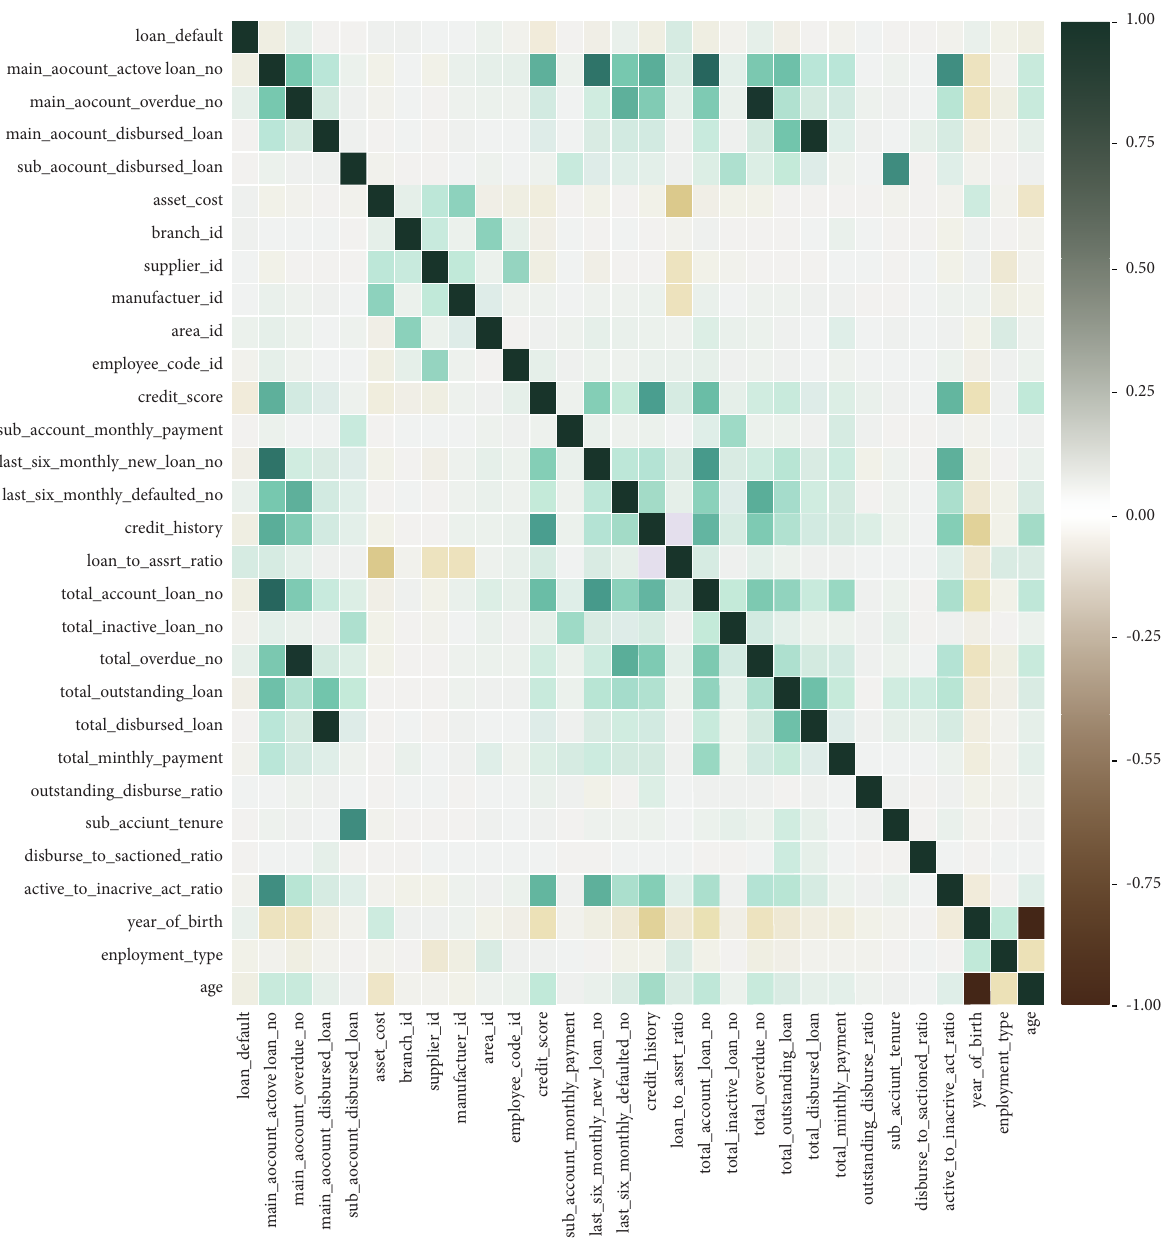
Figure 1: Relation coefficients heat